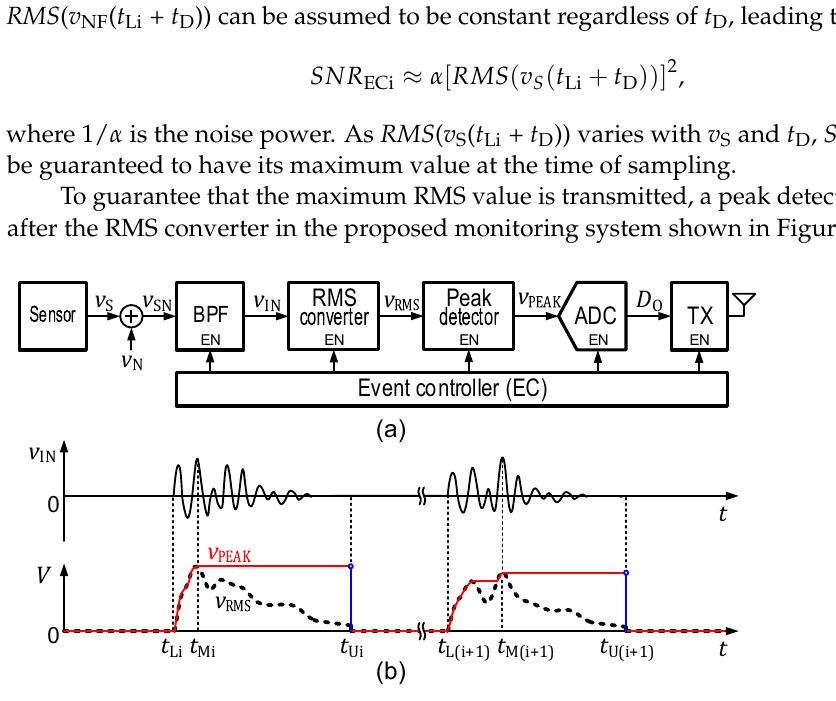
Figure 6. Proposed event-driven monitoring system. ( a ) Block and ( b ) timing diagrams.